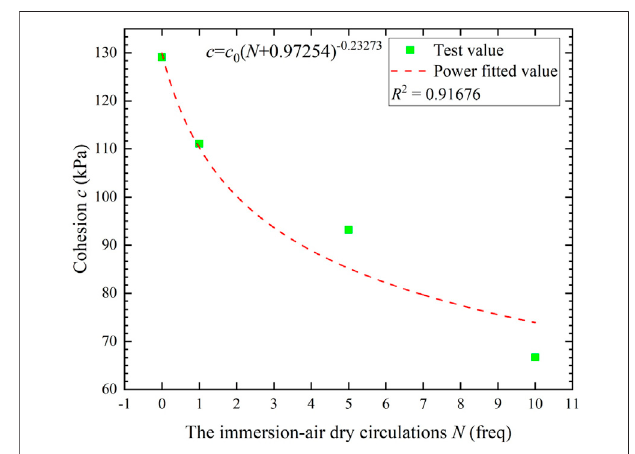
FIGURE 13 | Cohesive deterioration evolution curve of